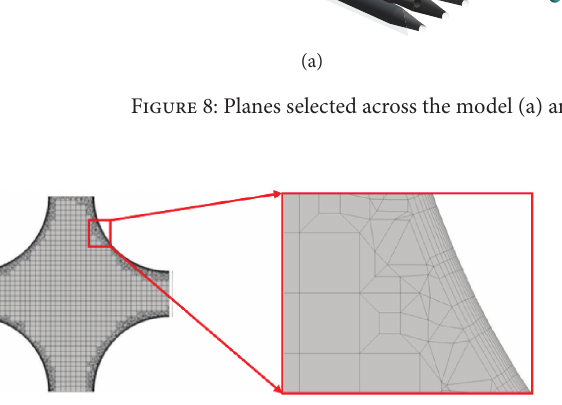
Figure 9: Subchannel mesh distribution with near-wall mesh